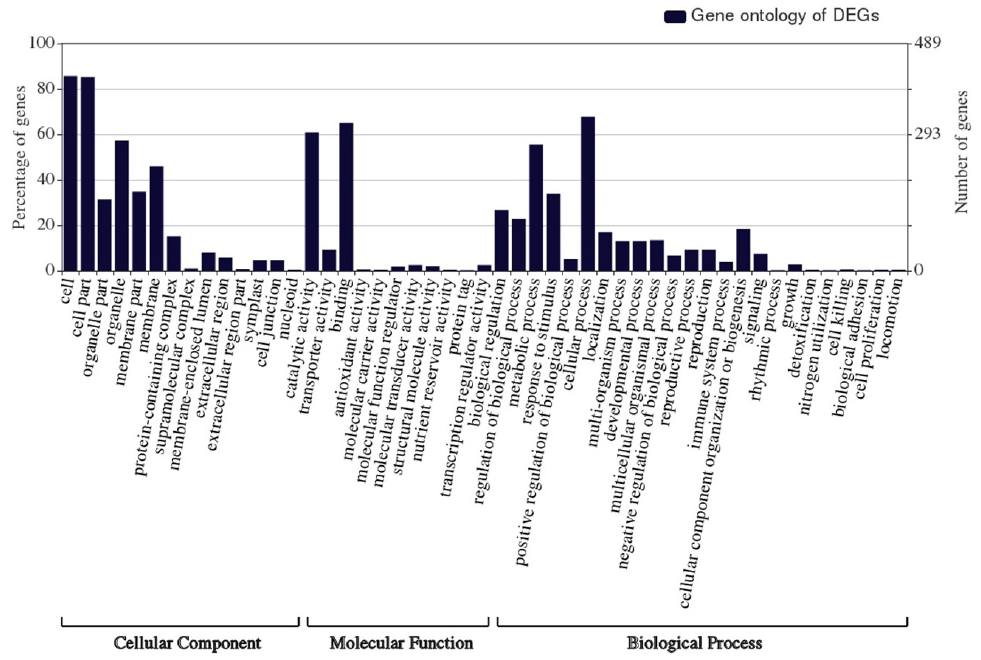
ff erentially expressed genes by the WEGO tool. Agronomy 2020 , 10 , x FOR PEER REVIEW